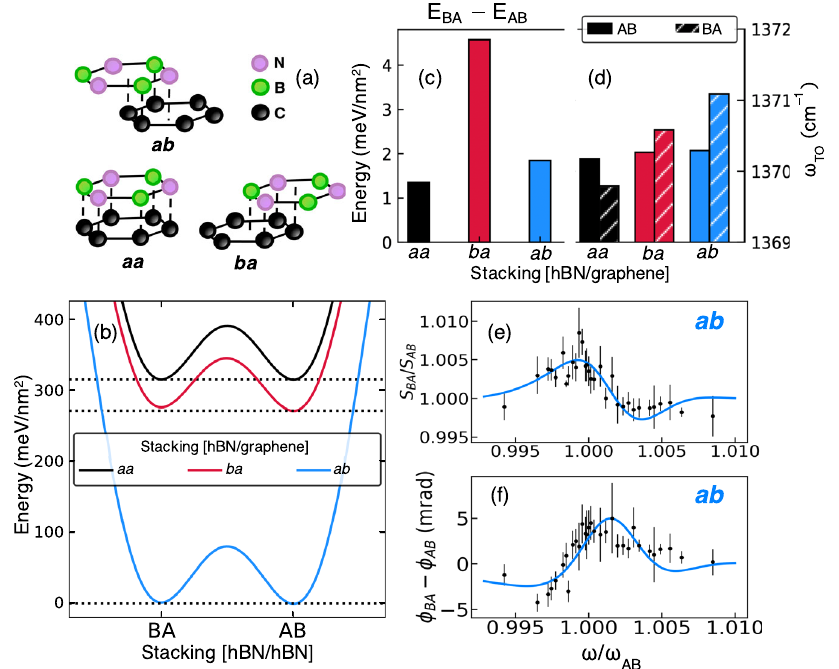
Fig. 3 Graphite substrate controls the AB/BA contrast in t-hBN. Uppercase notation (e.g., AB, BA, etc.) is reserved for hBN – hBN stacking con fi gurations, whereas the lower case is utilized to describe various hBN stacking options on graphite (e.g., aa , ba , etc.). a Schematic of hBN/graphite stacking con fi gurations. b Stacking energy landscapes for all three commensurate hBN/graphene con fi gurations. Dashed black horizontal lines highlight the subtle energetic preference of AB over BA stackings. c Plot of the calculated BA – AB energy difference and d TO frequency shift for each commensurate hBN – graphene stacking. e Data points reproduce the spectrum of S BA / S AB in Fig. 2c (with the same error bars) plotted using a normalized frequency horizontal axis. Solid line: spectrum of the scattering amplitude calculated with the lightning-rod model. f Similar to e , data points reproduce the spectrum of ϕ BA – ϕ AB from Fig. 2f. For consistency with Fig. 2, the solid line uses the same oscillator strength and damping (not obtainable in this model) extracted from the Fig. 2i AB fi tting